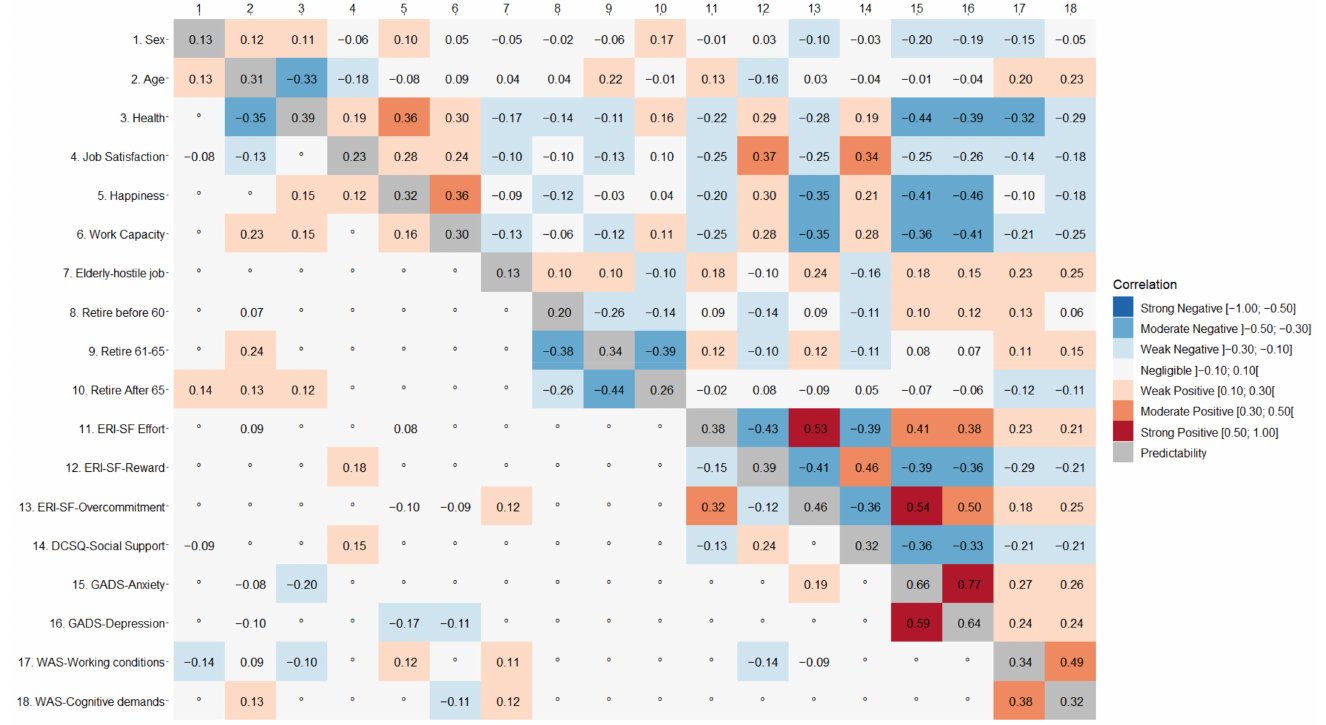
Figure 6. Correlations (upper triangle), partial correlations (lower triangle), and predictability values (diagonal) for the external validation of the Work Annoyance Scale (WAS) in Cohort 2 ( n = 655). ERI-SF: Effort-Reward Imbalance Questionnaire-Short Form; DCSQ: Demand-Control-Support Ques- tionnaire; GADS: Goldberg Anxiety and Depression Scale. The symbol “ ◦ ” indicates a partial correlation shrunk to zero. In the legend, the outward facing brackets indicate that the value is not included in the interval, while the inward facing brackets indicate that the value is not included in the